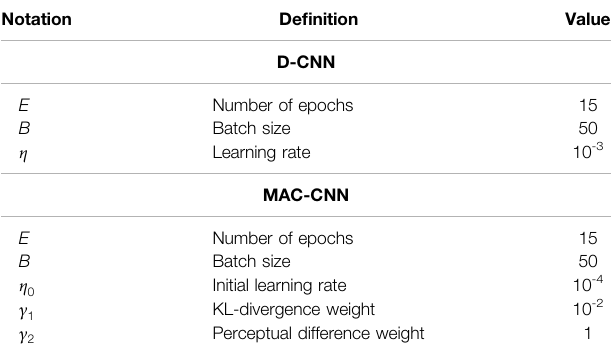
TABLE 2 | D-CNN and MAC-CNN training